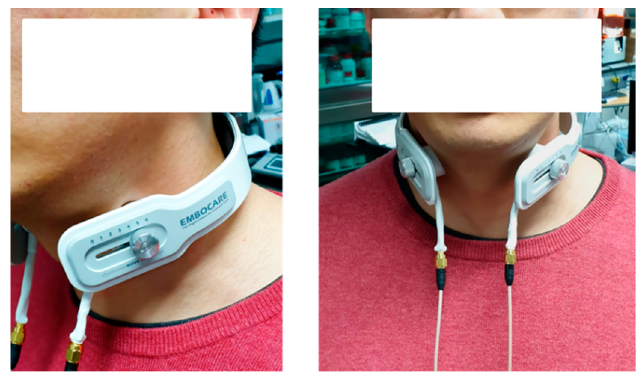
Figure 8. Placement of the wireless neckband carotid wearable ultrasound Doppler system prototype.